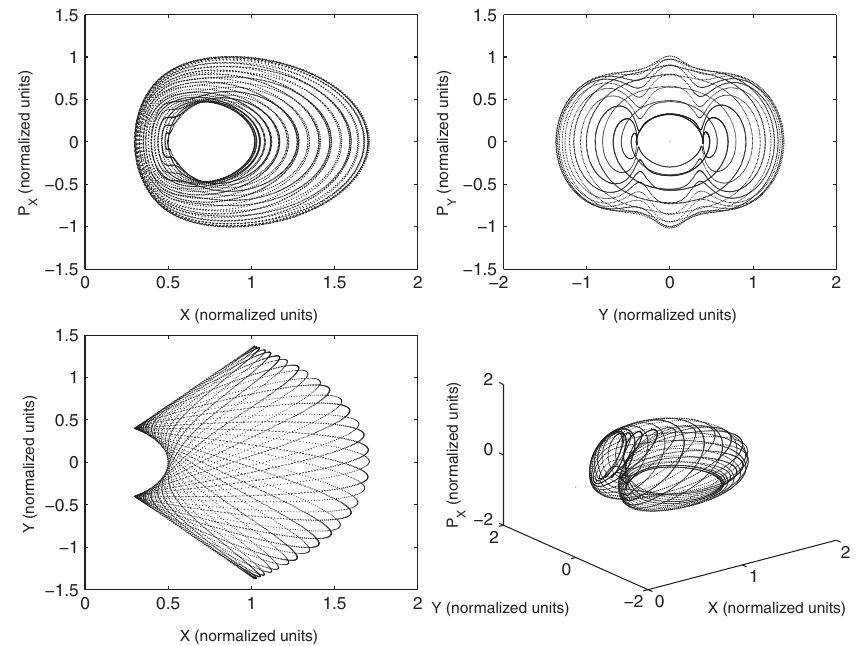
FIG. 5. An exactly integrable case, separable in polar coordinates. The four subplots show the same projections as in previous figures. The initial conditions are x ¼ 0 : 3 , p